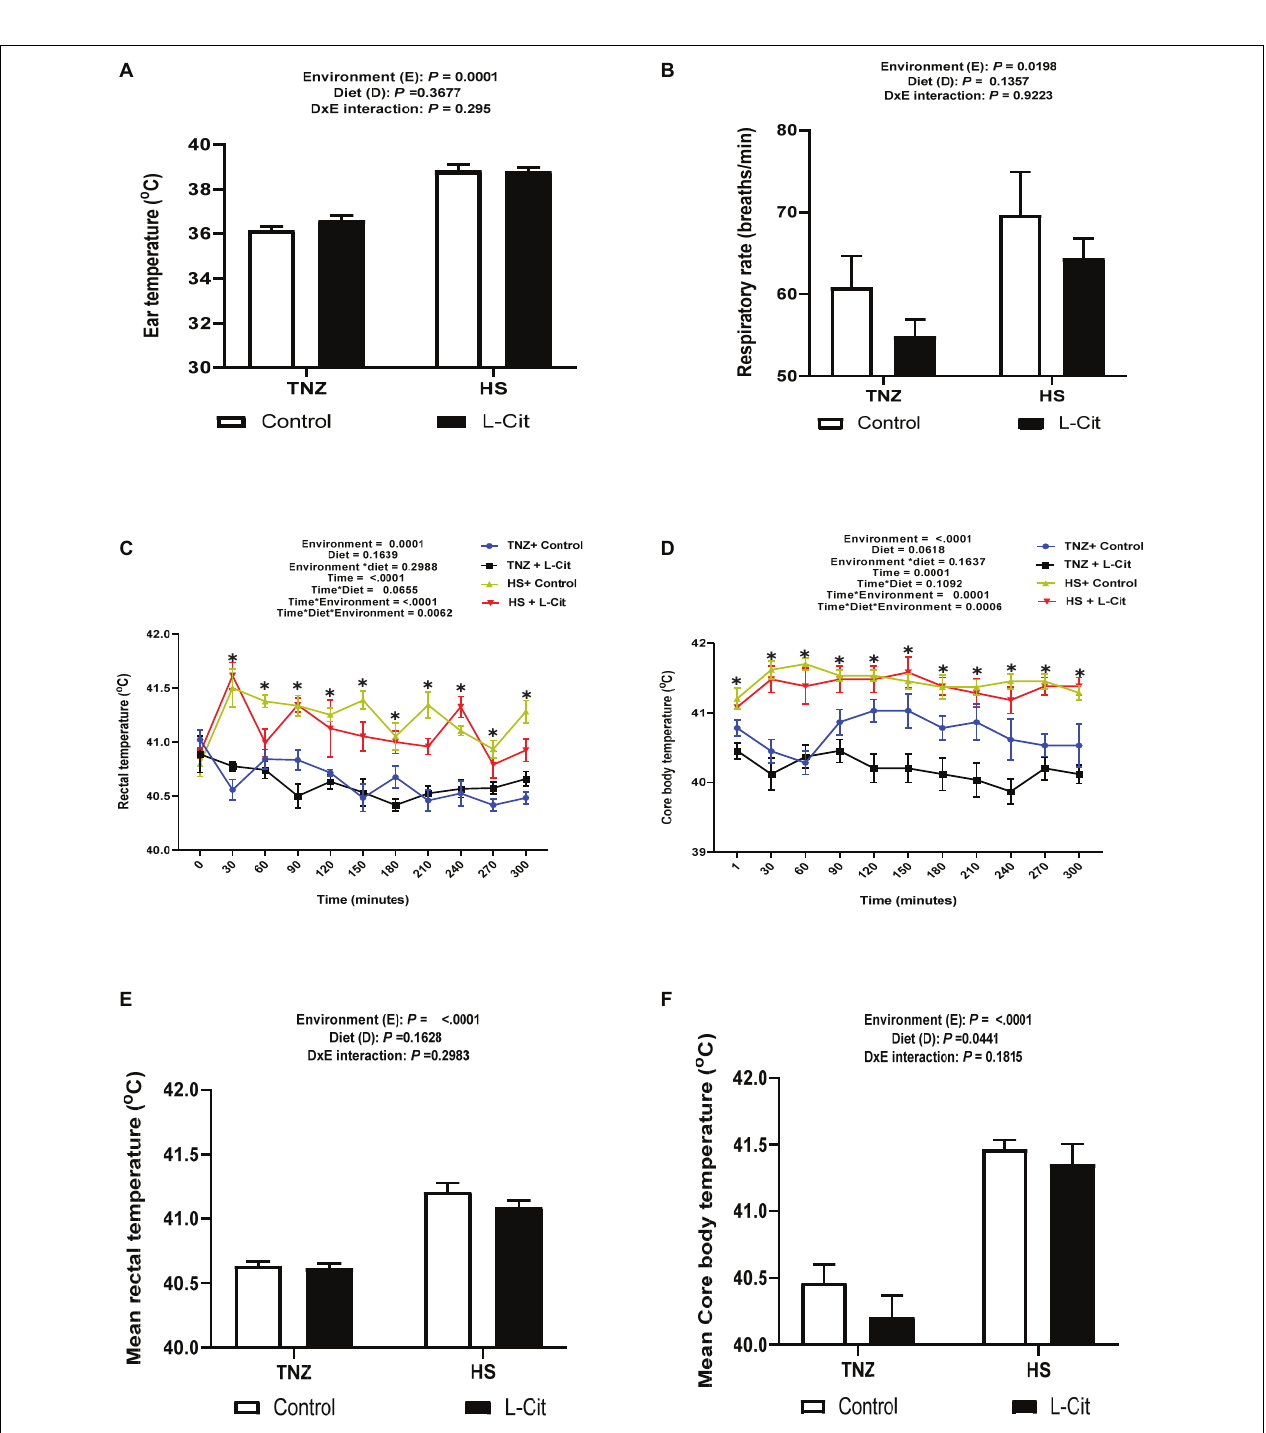
FIGURE 1 | Effect of L -citrulline supplementation on thermotolerance of broilers during acute heat stress. (A) Ear temperature. (B) Respiratory rate. (C) Rectal temperature. (D ) Core body temperature. (E) Mean rectal temperature. (F) Mean core body temperature Data are presented as mean ± SEM ( n = 12). TNZ, thermoneutral; HS, heat stress. *Indicates significant effect of treatments at P < 0.05.